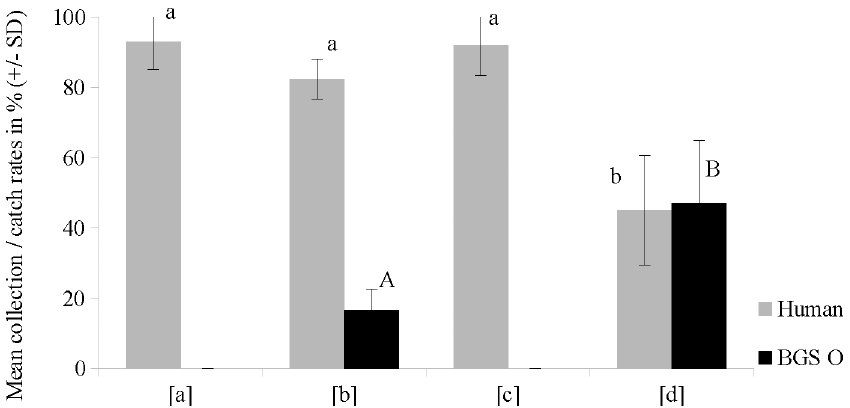
Fig 6. Human collection rates (black) and BGS catch rates (grey) (means ± standard deviation) of Ae . aegypti in laboratory room tests of the FFS in combinaton with Stericlin dispensers for catnip oil dispersal (experiment 4). Test scenarios: [a] no repellent, BGS O absent; [b] no repellent, BGS O present; [c] repellent, BGS O absent and [d] repellent, BGS O present (= push-pull situation). Different letters indicate significant differences in mean BGS trap catch rates (uppercase) at p < 0.0004 (Mann-Whitney-U-test, n = 10) or mean human landing rates (lowercase) at p < 0.0009 (Mann-Whitney-U-test, n = 10). doi:10.1371/journal.pone.0129878.g006 Nepetalactone quantities were greater in samples taken from the FFS: mean quantities col- lected from all positions at 0 min (81.4 ± 37.5 μ g/m 3 ) were significantly greater than mean olfactometer collections (54.9 ± 13.3 μ g/m 3 ) (U = 43; Z = -2.363; P = 0.0181). Overall, mean nepetalactone quantities (pooled from all positions and every point in time) were significantly greater in FFS collections (91.0 ± 26.3 μ g/m 3 ) compared to collections from the SHS (57.9 ± 65.0 μ g/m 3 ) (U = 2237; Z = -7.3949; P = 1.41E-13). At sampling point 0 min, mean nepetalactone quantities of the SHS (40.0 ± 77.9 μ g/m 3 ) were also significantly lower than mean olfactometer collections (U = 57; Z = -3,2079; P = 1.34E-03).